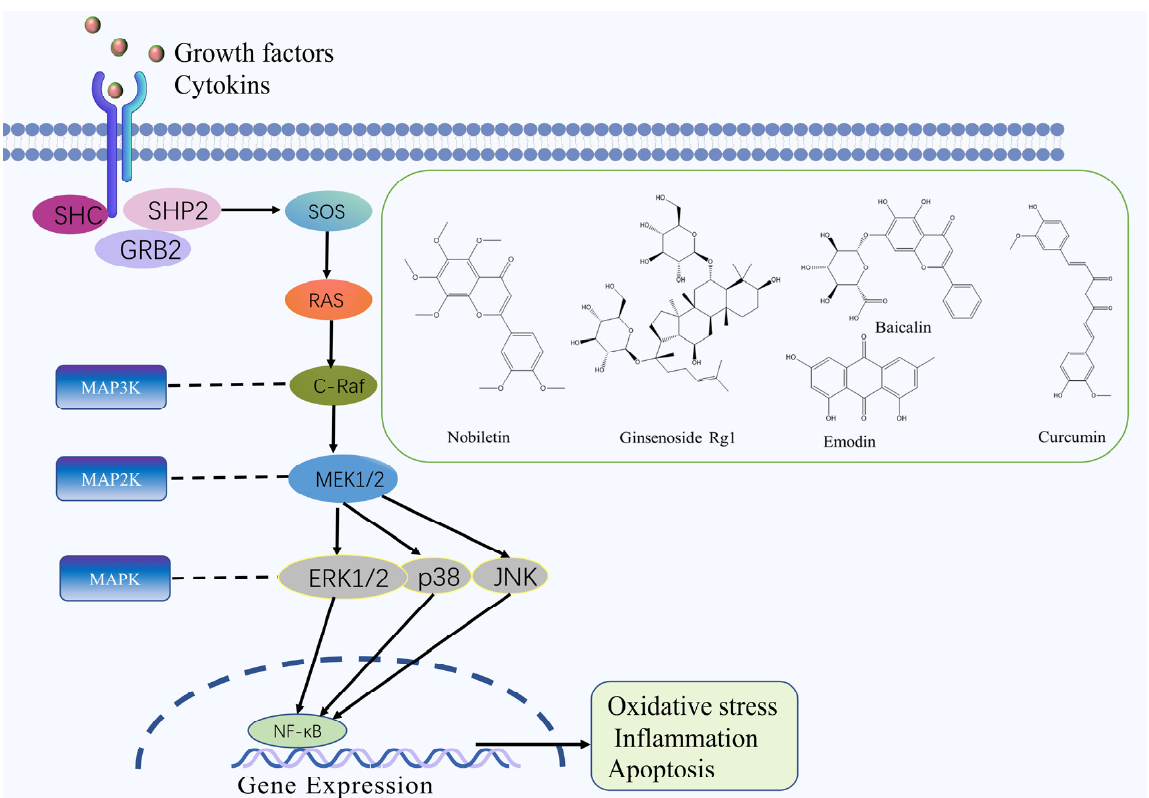
Figure 3. MAPK signaling pathway and the chemical structure of natural